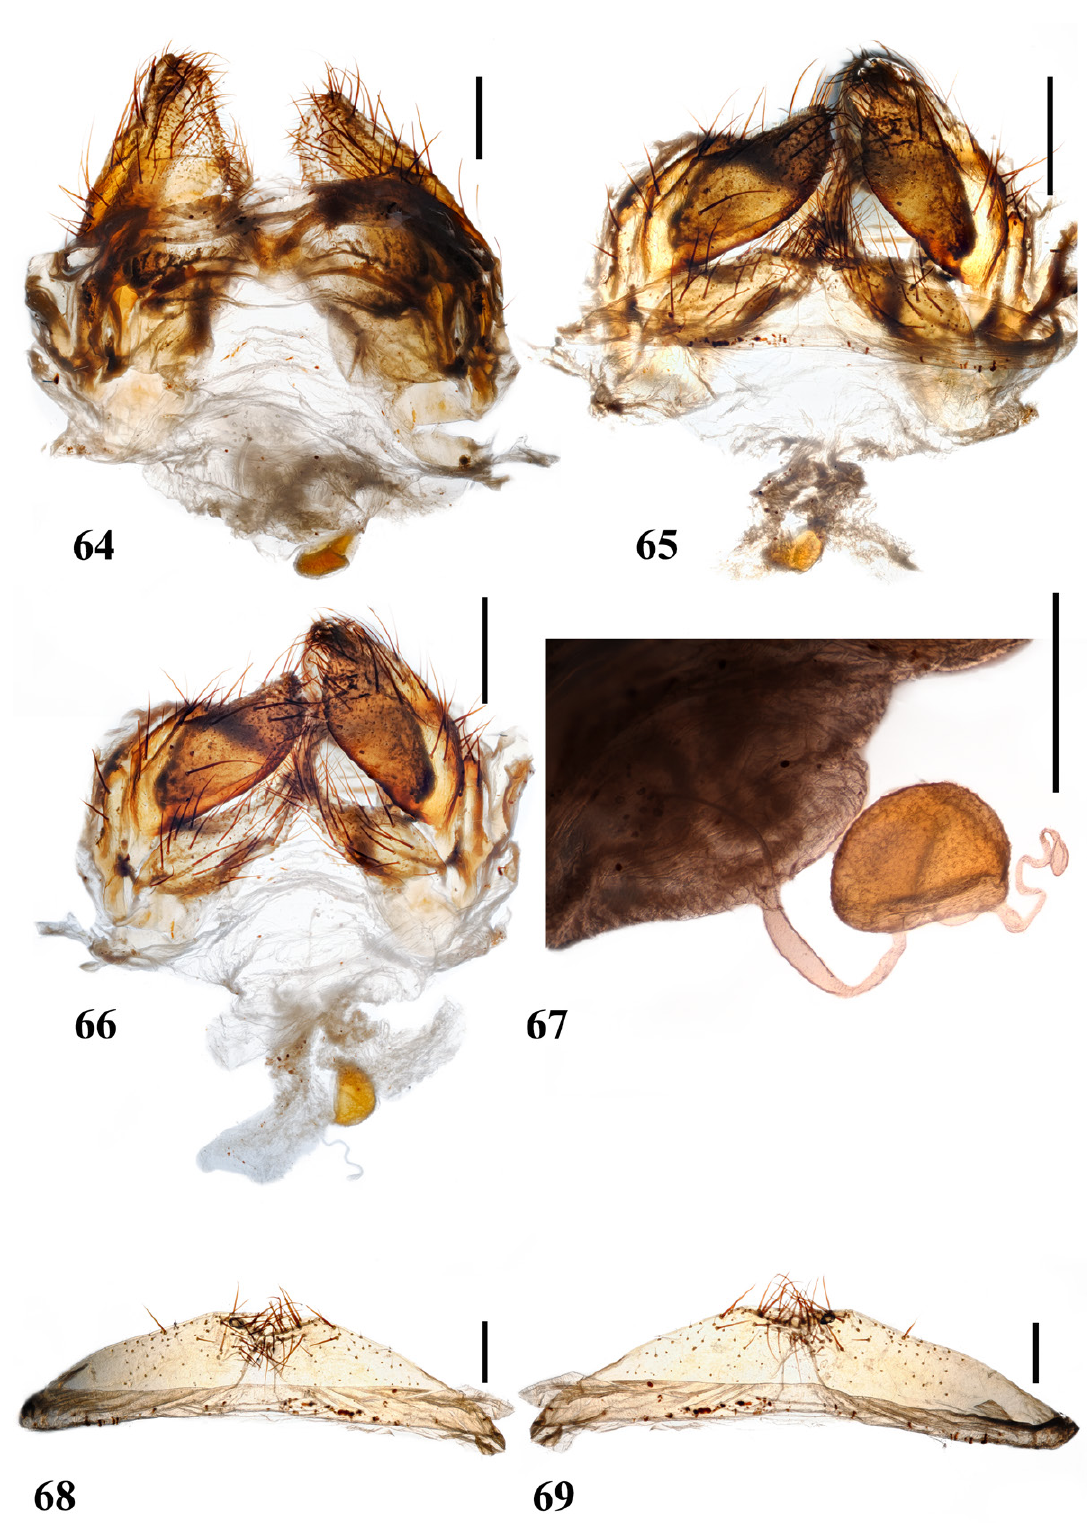
Figs 64–69. Oryctopterus yeshwanthi sp. nov., female genitalia. Holotype (UASB). 64 . Dorsal view. 65 . Ventral view with VIII sternite intact. 66 . Ventral view without VIII sternite. 67 . Spermatheca. 68 . VIII Sternite, dorsal view. 69 . VIII Sternite, ventral view. Scale bars = 1